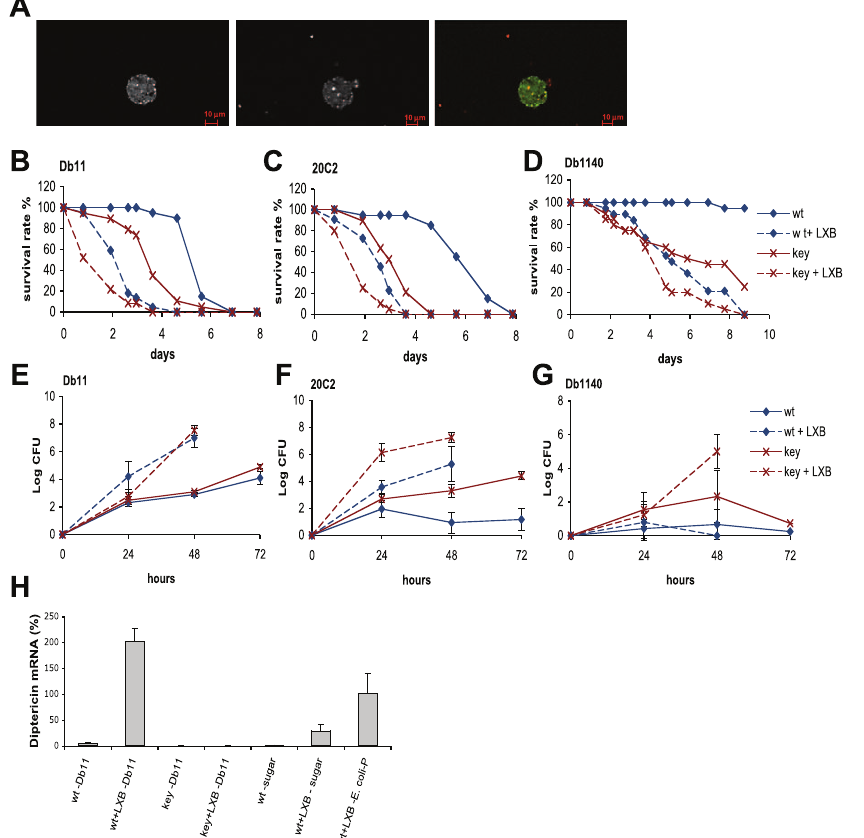
Figure 7. Phagocytosis Plays an Essential Role in the Control of Intestinal S. marcescens Infection (A) A pTEP1 - GFP -expressing hemocyte that has phagocytosed Db11-DsRed bacteria. The picture was taken with the apotome microscope: left-panel (GFP); central panel (DsRed); right panel (merge). pTEP1 - GFP expression specifically labels hemocytes. Bacteria that have been engulfed appear yellow in the right panel. (B–D) Phagocytosis inactivation through the injection of latex beads ( þ LXB) leads to the earlier demise of treated flies as compared to control (untreated flies). (B) Db11: median survival time (LT50 in days), wt: 5.63, wt þ LXB: 2.63, key : 3.63, key þ LXB: 1.92 (LXB-treated versus untreated flies: p , 0.0001; wt þ LXB versus key þ LXB: p ¼ 0.0089). (C) 20C2: wt: 6.88, wt þ LXB: 2.63, key : 3.63, key þ LXB: 1.292 (LXB-treated versus untreated flies: p , 0.0001; wt þ LXB versus key þ LXB: p ¼ 0.0045). Db1140 (D). Latex bead–injected flies usually survive the procedure well when fed on sucrose alone (not shown). (E–G) The hemolymph of latex bead-injected and nontreated surviving flies (batches of 20 flies) that had been feeding on Db11-GFP (E), 20C2-GFP (F), Db1140-GFP (G) was collected and plated on agar plates containing the appropriate antibiotics. The counts were performed only up to 48 h in the